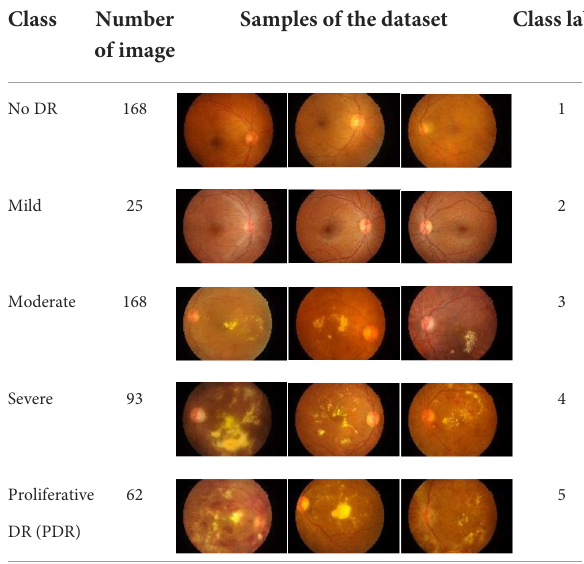
TABLE 3 The description of the IDRiD